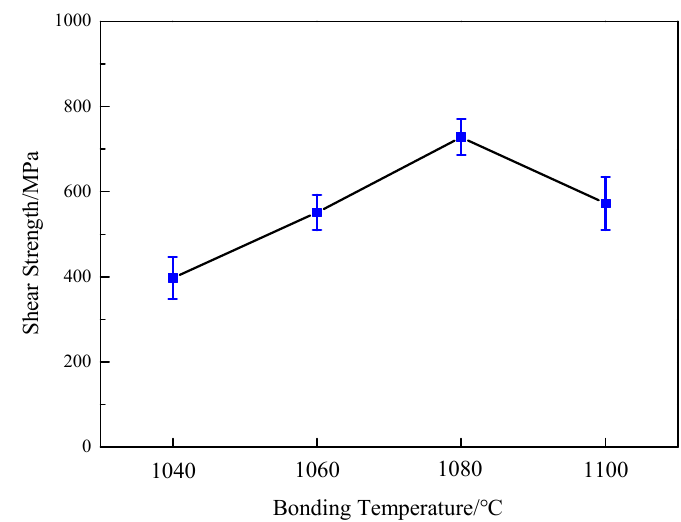
Figure 5. Effect of bonding temperature on the shear strength of TLP-bonded GH4169/BNi-2/GH4169